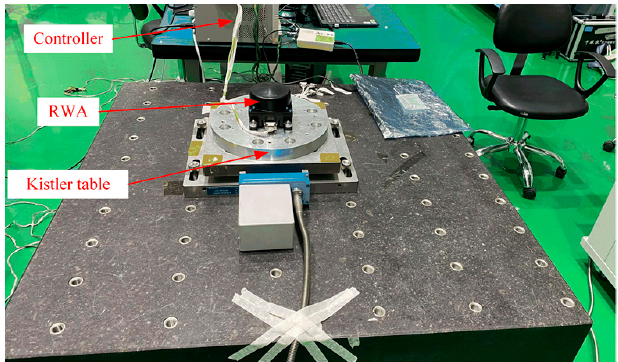
Figure 4. Test site for the RWA disturbance.